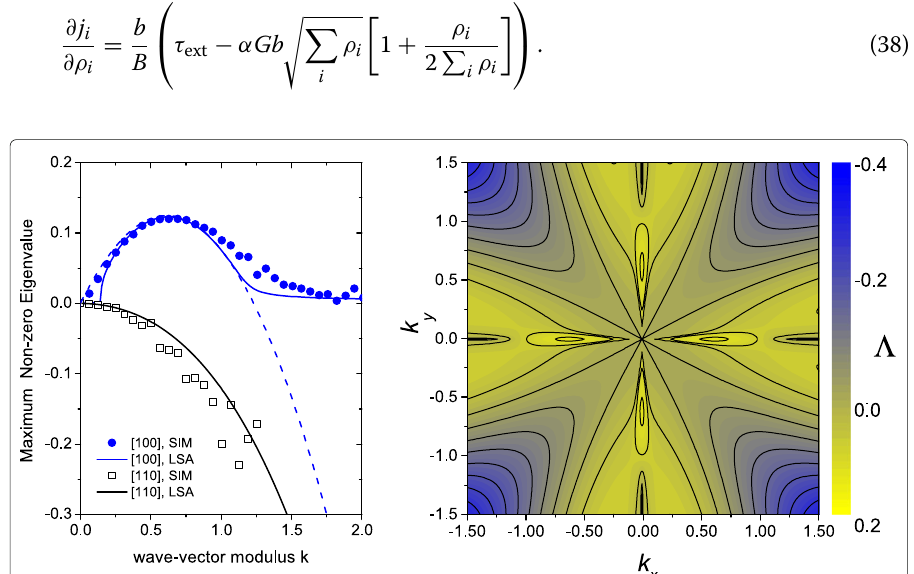
Fig. 1 Left: Growth rates of fluctuations; dashed blue line: growth rate for wave-vectors aligned with the [10] lattice directions according to linear stability analysis (LSA), blue line: growth rate for fluctuations near [10], black line: growth rate for wave-vectors flaligned with the [11] lattice directions; discrete symbols: growth rates deduced from Fourier modes of the numerical solution for a Gaussian white noise as initial condition. Right: growth rates for fluctuations according to LSA over the entire domain of wave vectors. Parameters: A = D = 0.1, α = 0.3, τ ext =